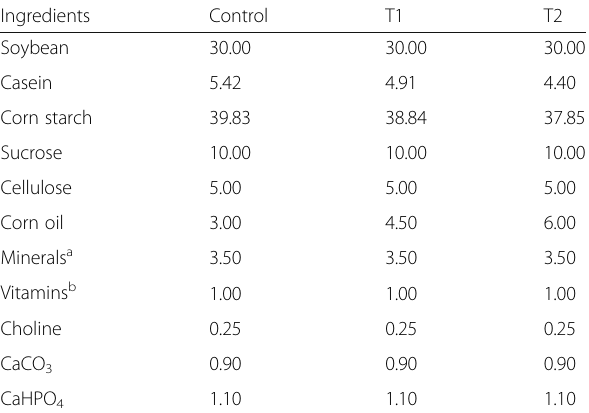
Table 2 Composition of the experimental diets (g/100 g dry matter) formulated according to Teshima et al., 2000